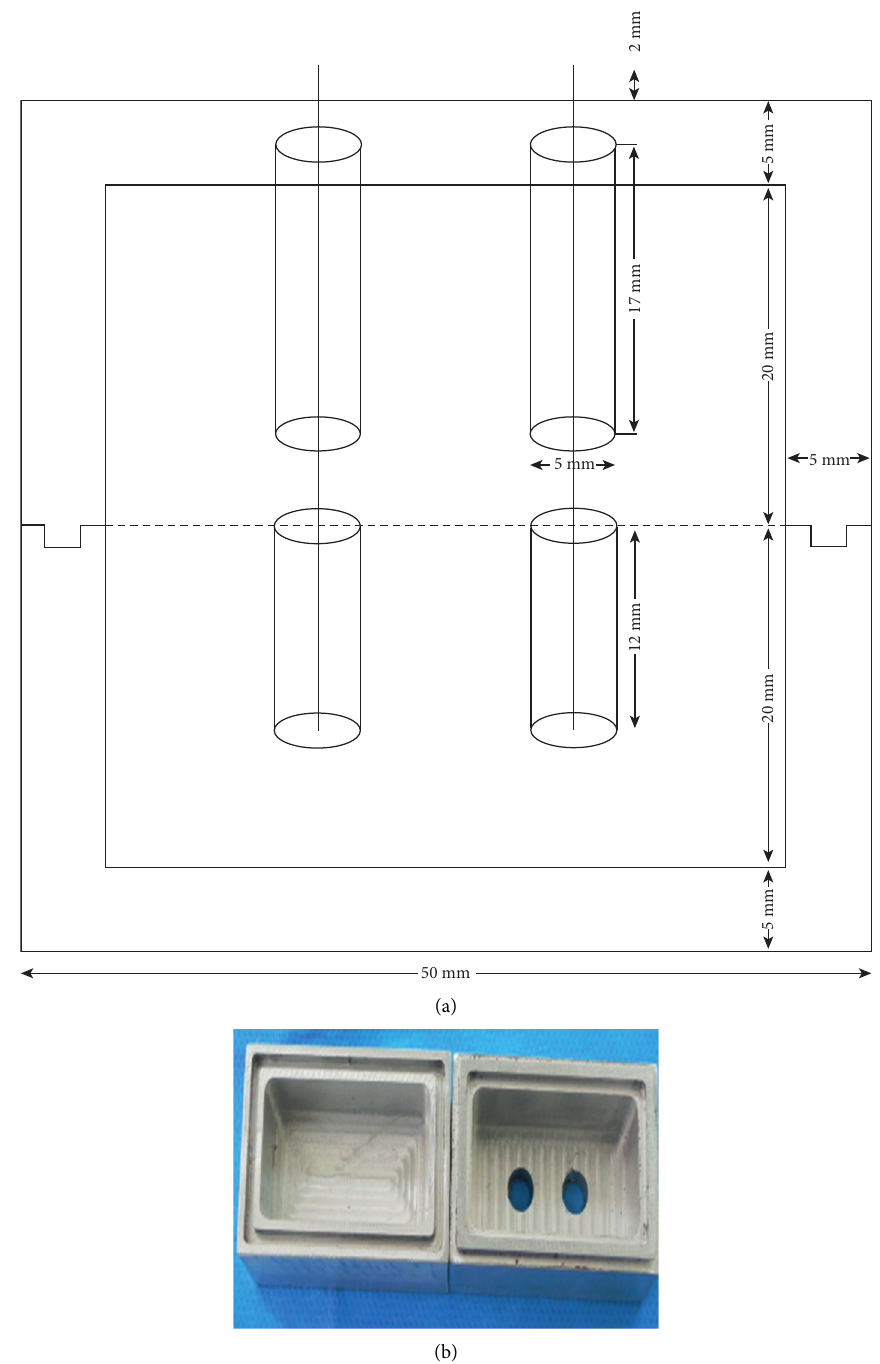
Figure 1: (a) Dimensions of aluminum index. (b) An aluminum index to unify the